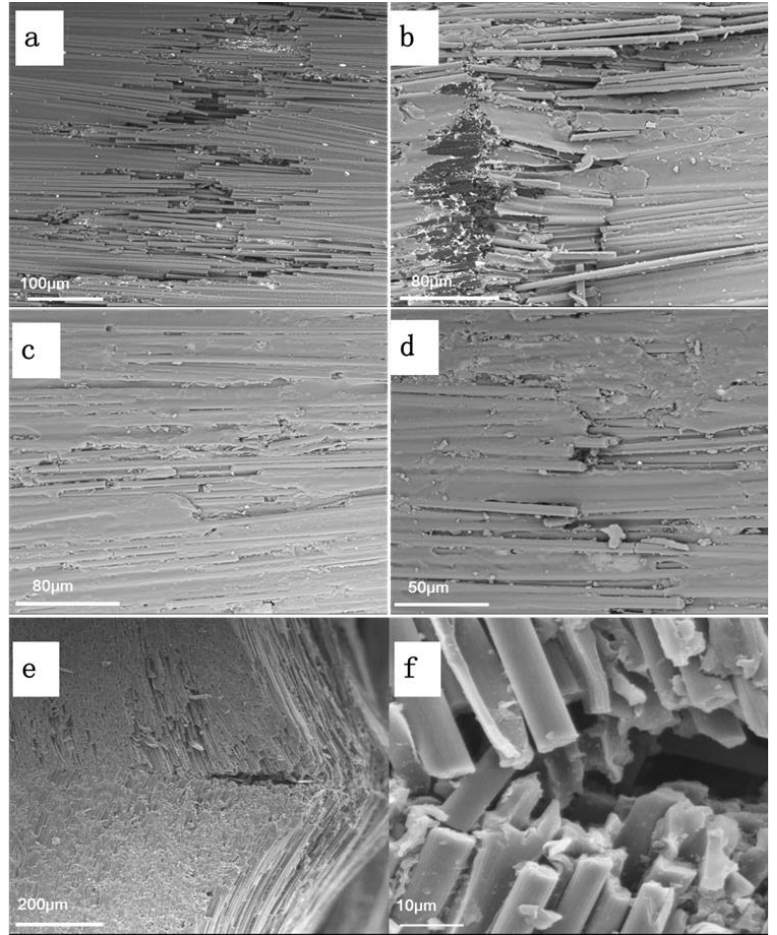
Figure 6. SEM observation of the CF/EP specimens under different current loading (top view): ( a ) bottom layer and ( b ) upper layer of the specimens under 3 A; ( c ) bottom layer and ( d ) upper layer of the specimens under 5 A; and ( e , f ) the side view of the buckling area on the upper layer of the specimens under 5 A.